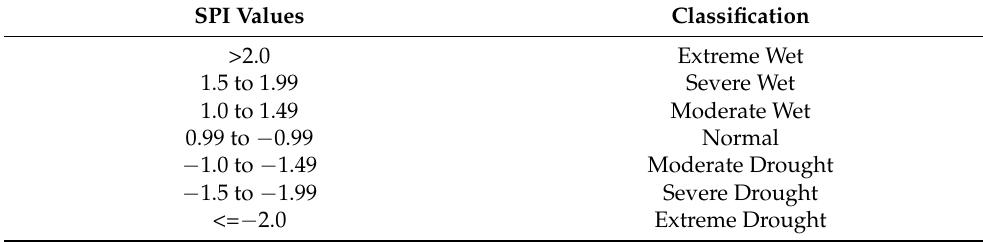
Table 2. General SPI classification